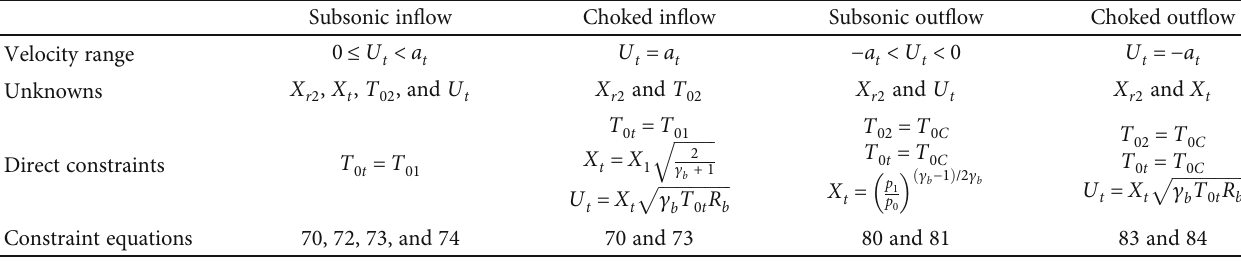
Table 2: Solution summary for boundary conditions.